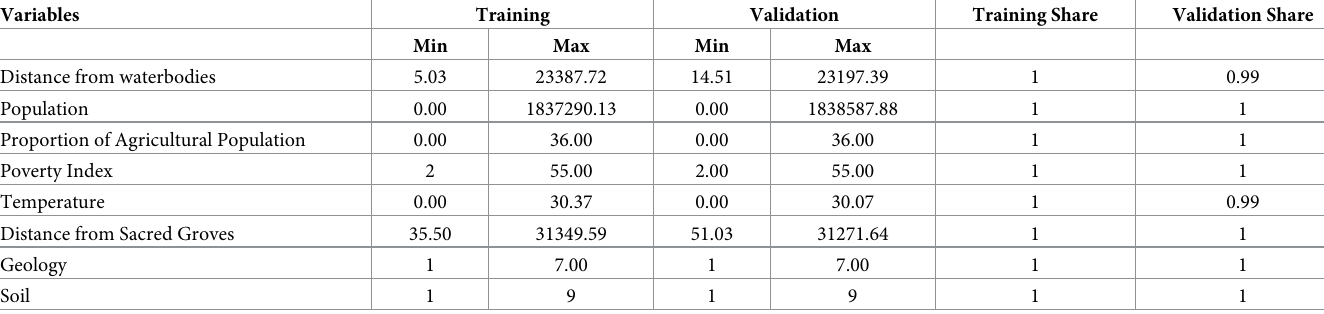
Table 4. Accuracy of prediction of training and validation for the exploratory variables.